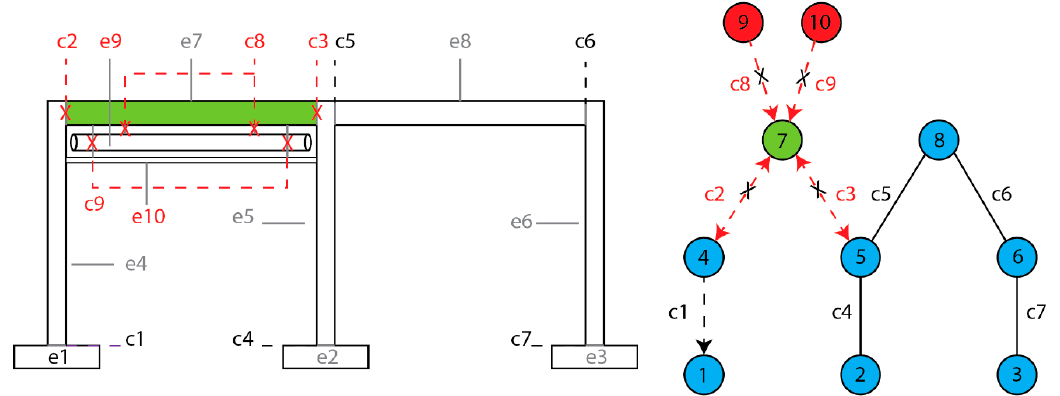
Figure 9. The extraction of element e7 considering the path P1 initiates the removal of connections c9, c8, c2, and c3 and the removal of elements e9 (ducts) and e10 (ceiling). For path P2, the only difference lies in the extra removal of element e4 (column) and the disconnection of c1.